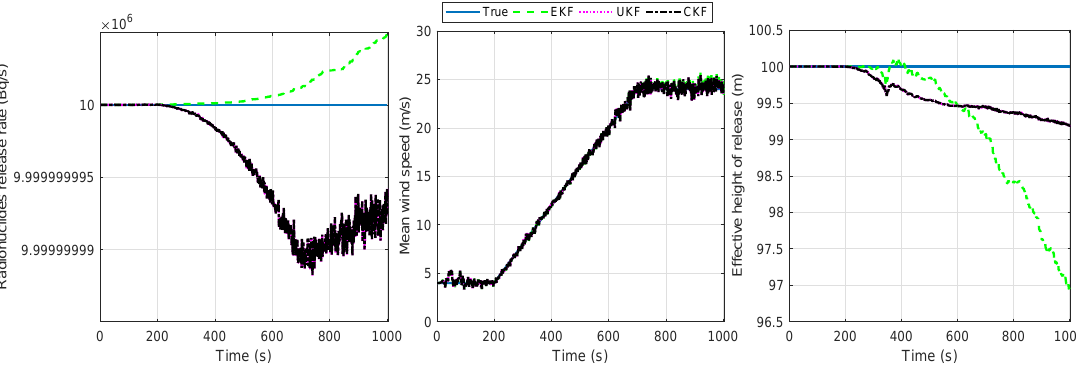
Figure 4. True, measured, and estimated dose rates at detectors D1 to D8 for variation in wind speed.